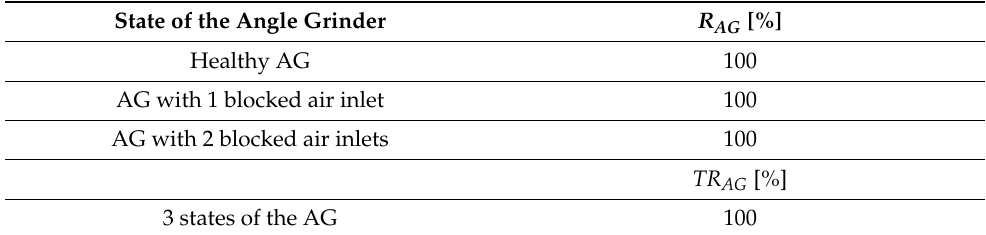
Table 5. Values of TR AG and R AG for using of BCAoMID − F, histogram, and SVM.